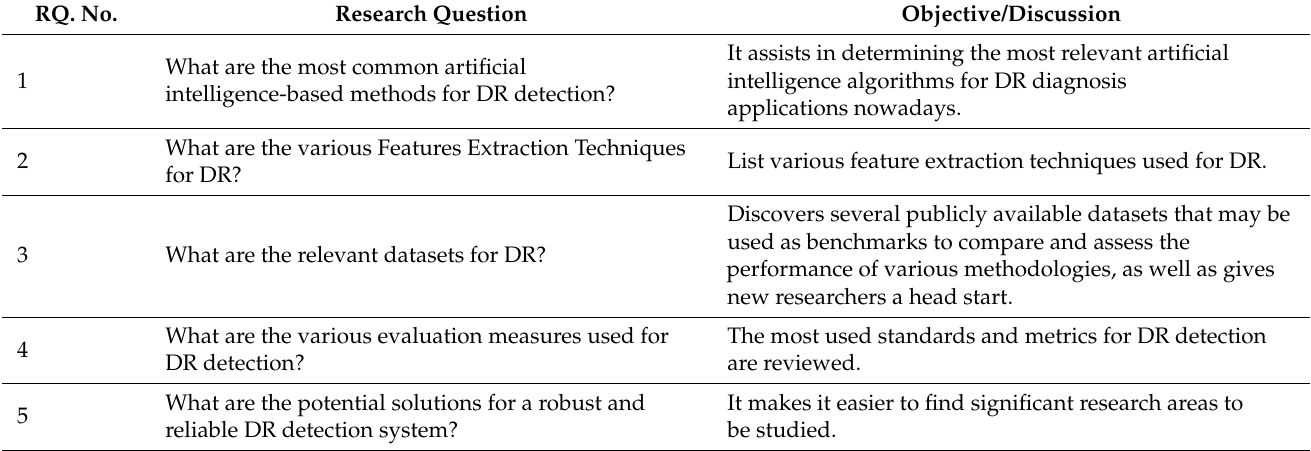
Table 2. Research